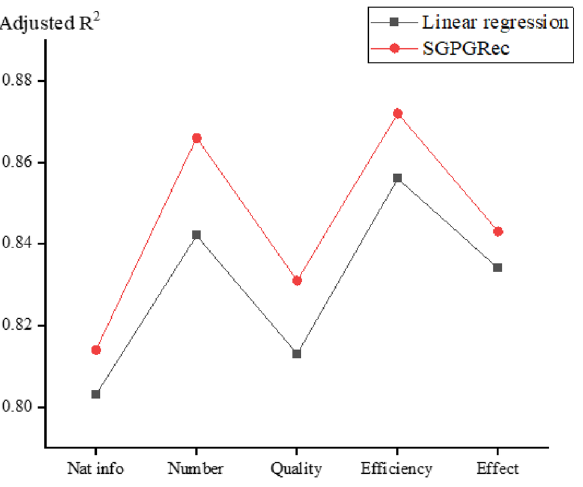
Figure 5. The performance of prosecutor portrait